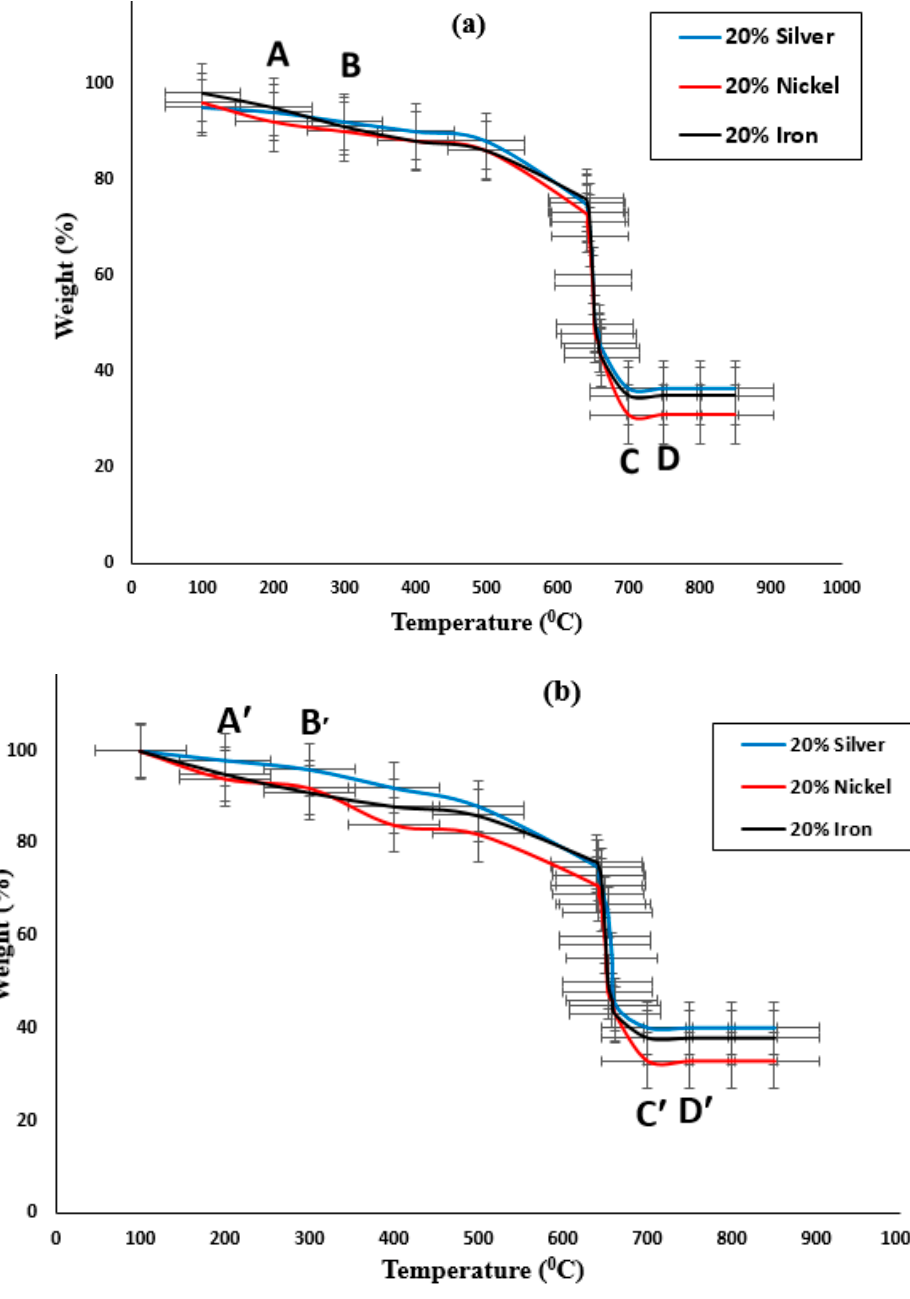
Figure 9. ( a ) TGA profile of the synthesized SWCNT together with error bars. ( b ) TGA profile of h -BN-CNT composites together with error bars.